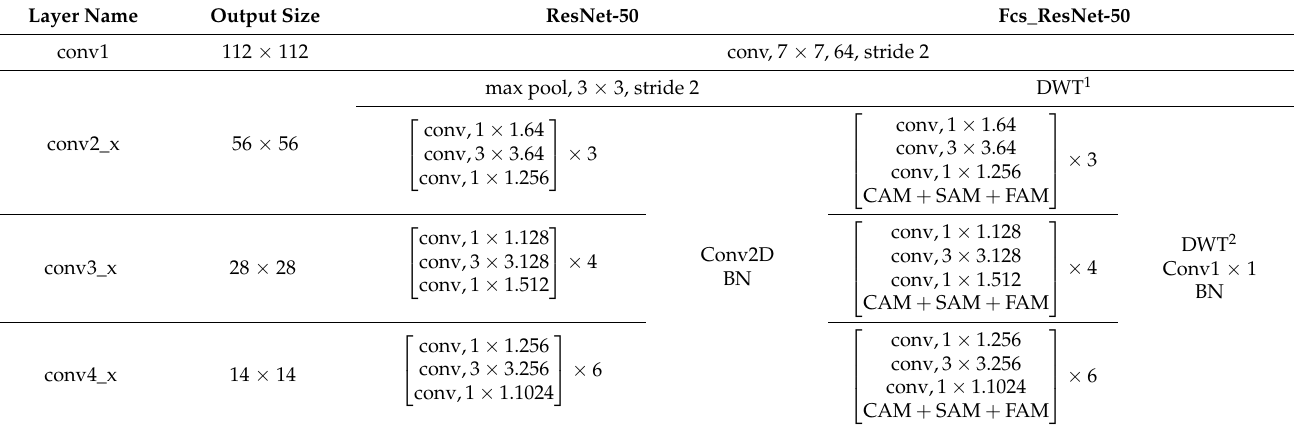
Table 1. Network structure of ResNet-50 and Fcs-ResNet-50(ours). The shapes and operations with specific parameter settings of a residual block are shown in brackets, with the numbers of blocks stacked. The right side shows different down-sampling performed by conv3_1, conv4_1, and conv5_1 with a stride of